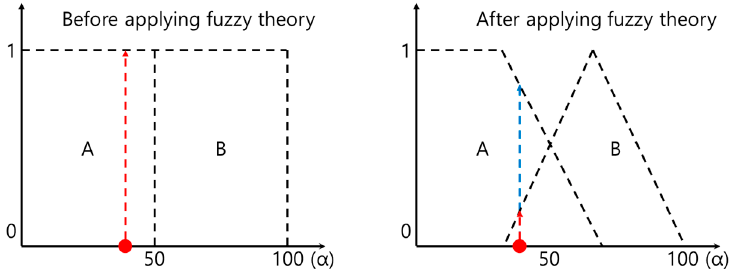
Figure 14. The many-valued logic of fuzzy theory.